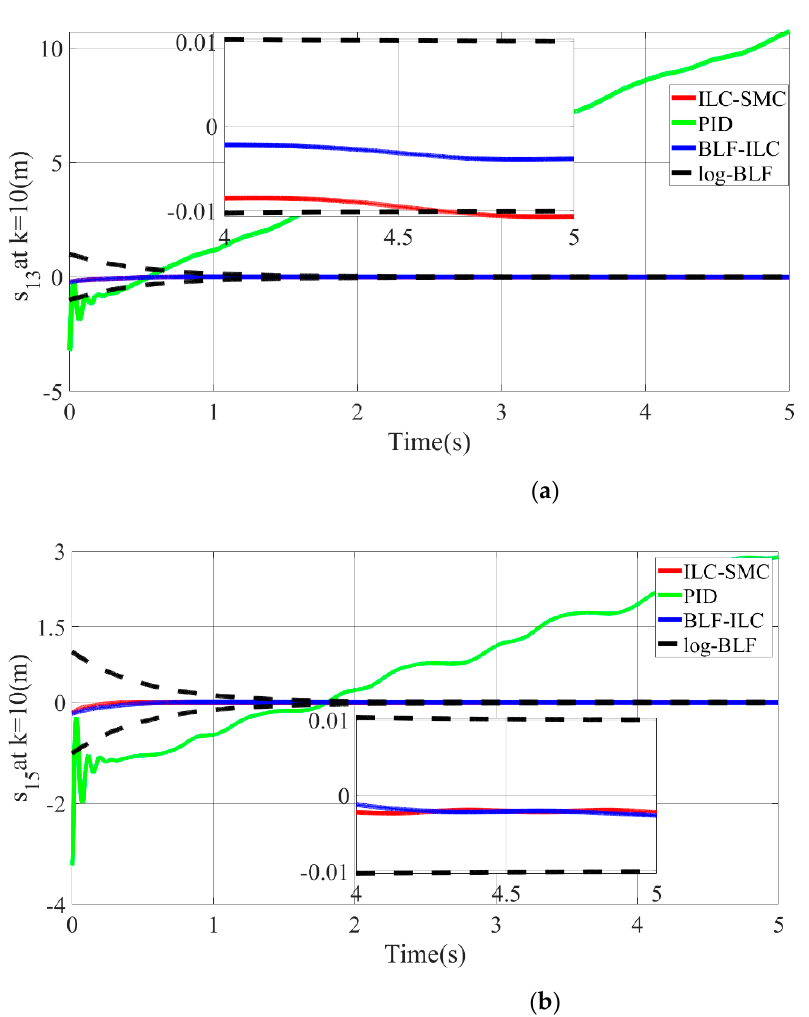
Figure 17. Comparison of simulation results with other control algorithms. ( a ) Position-tracking error curves of different control algorithms for PMA1. ( b ) Position-tracking error curves of different control algorithms for